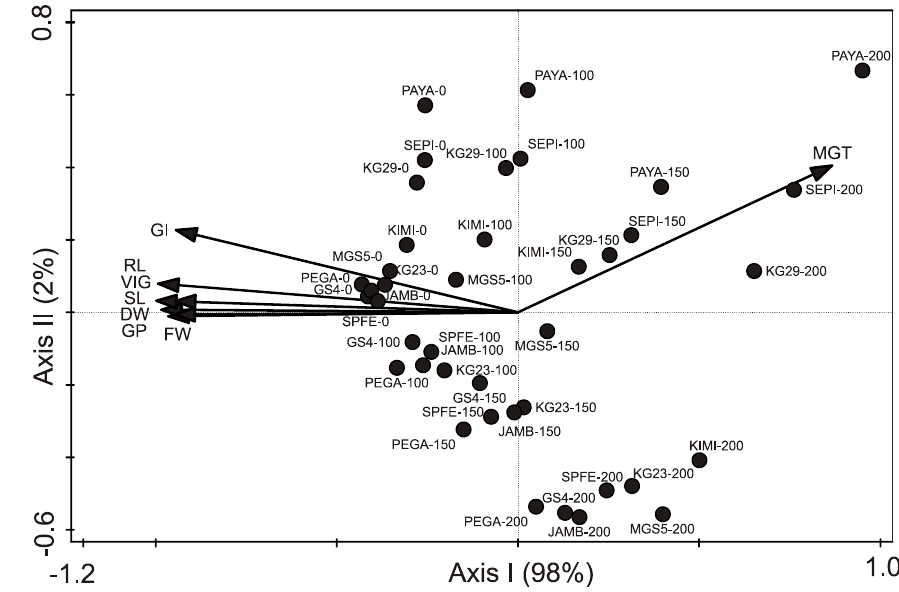
Figure 1. Non-metric multidimensional scaling ordination diagram (NMDS with Bray–Curtis similarity measure) of ten sorghum genotypes in four salinity treatments. Germination and growth parameters projected passively in ordination space. GP = germination percentage (%); GI = germination index; MGT = mean germination time (day); SL = seedling shoot length (cm); RL = seedling root